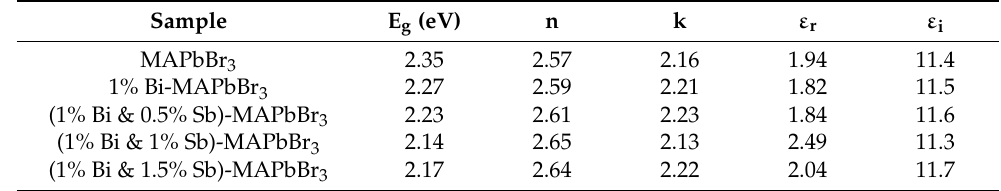
Table 1. E g , k, n and dielectric constants of undoped and Bi- and Sb- co-doped MAPbBr 3 films.